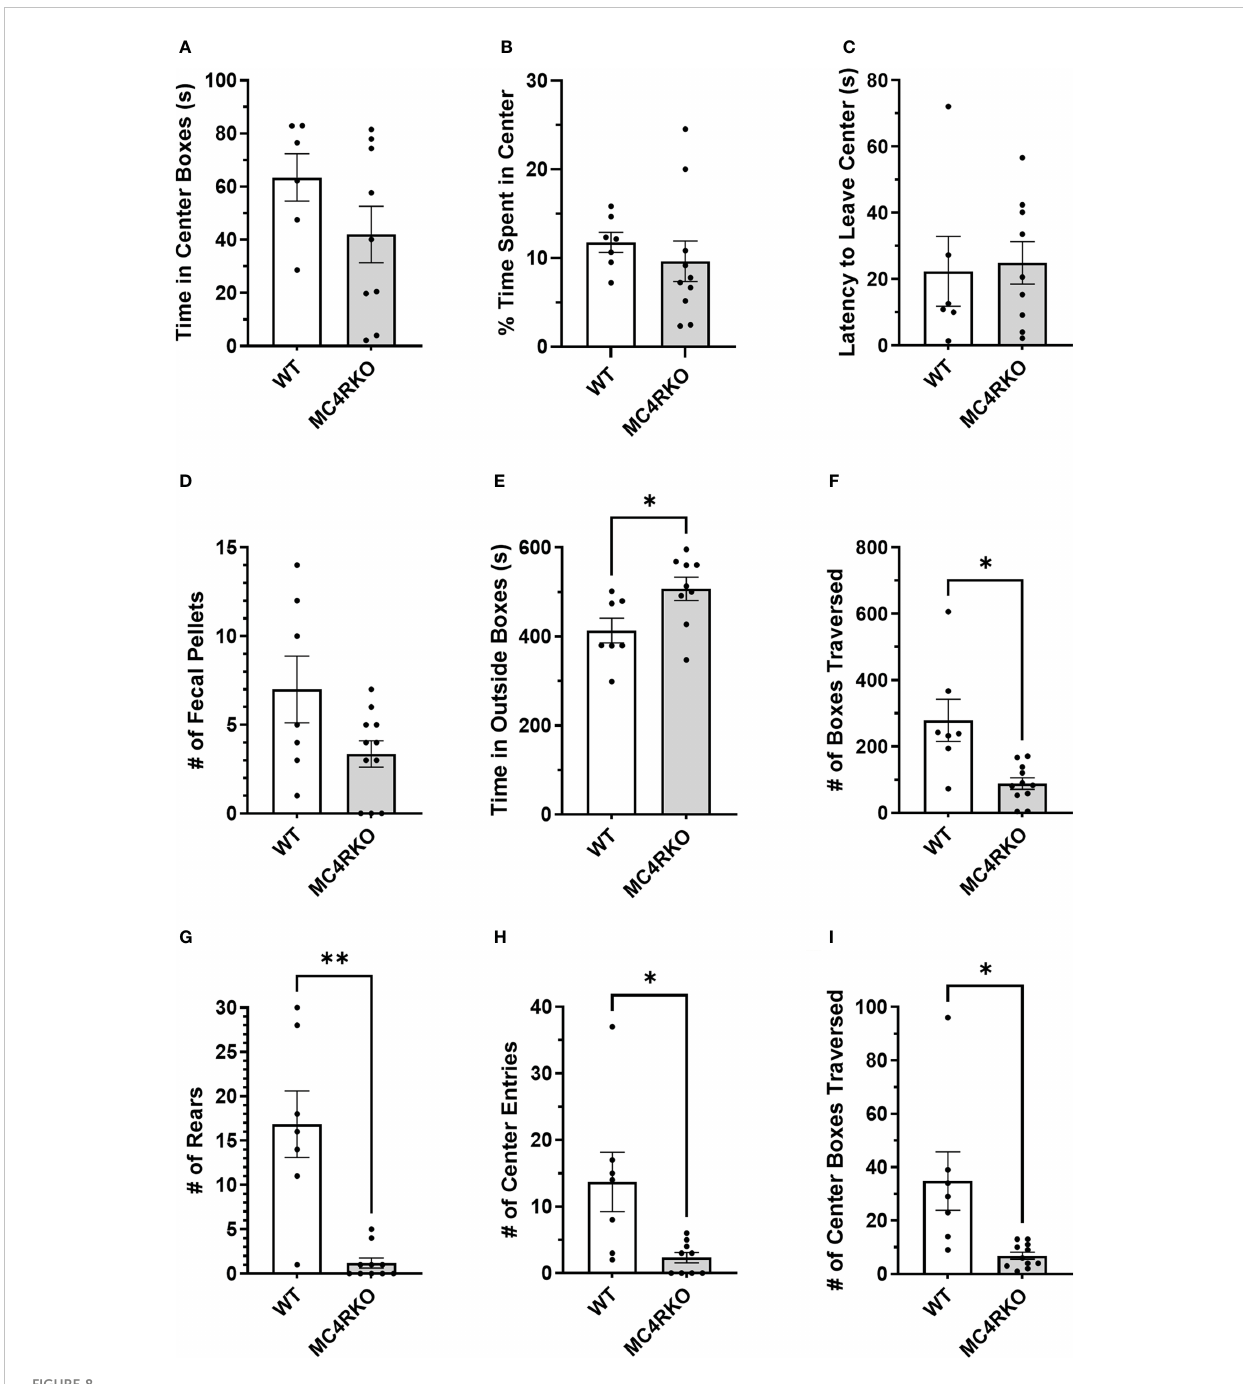
FIGURE 8 MC4RKO mice exhibit decreased locomotion in an open fi eld test. The time that each animal spent in the center boxes (A) , the percent of time spent in the center (B) , the latency to leave the center (C) , the number of fecal pellets produced during the test (D) , time spent in the outside boxes (E) , the number of boxes traversed (F) , the number of rears (G) , the number of entries into the center boxes (H) , and the number of center boxes traversed (I) is shown. WT=6-7 and MC4RKO=9-11 mice. Unpaired t-tests were used for graphs D-F and K; Unpaired Welch ’ s t-tests were used for graphs G-J. Graph F (p=0.029); Graph G (p=0.023); Graph H (p=0.006); Graph I (p=0.044); Graph J (p=0.0433). *p<0.05;